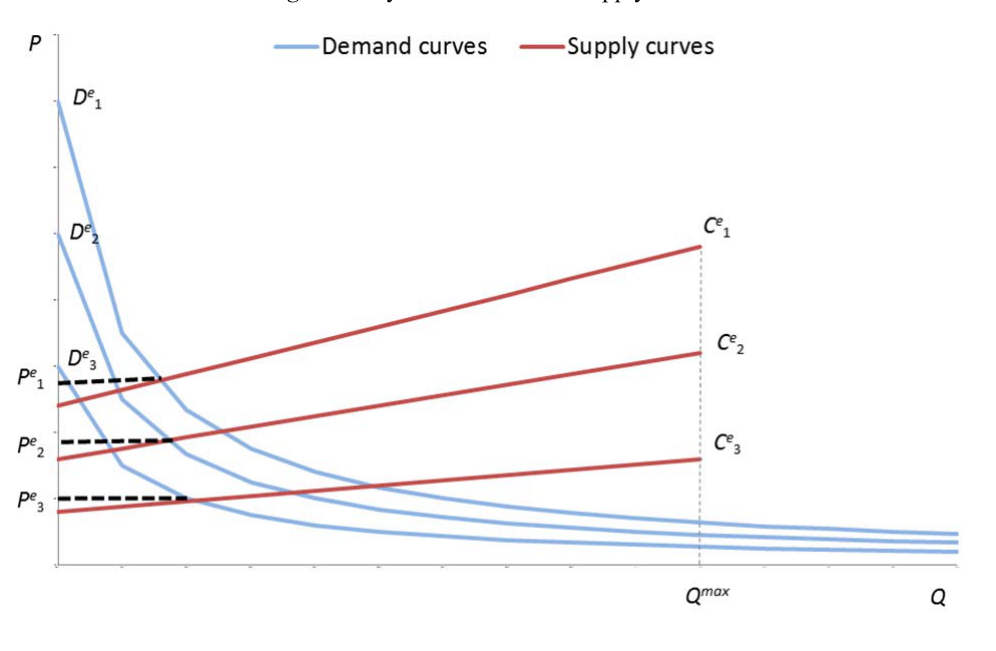
Figure 1. Stylised demand and supply